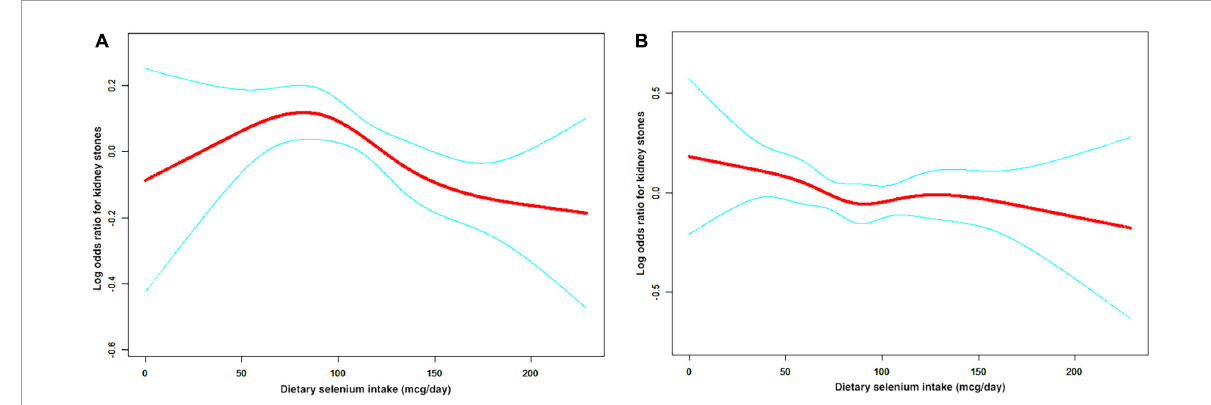
FIGURE4 The non-linear relationship between dietary selenium intakes and the risk of kidney stones in stratified analysis by sex. (A) male group, (B) female group.